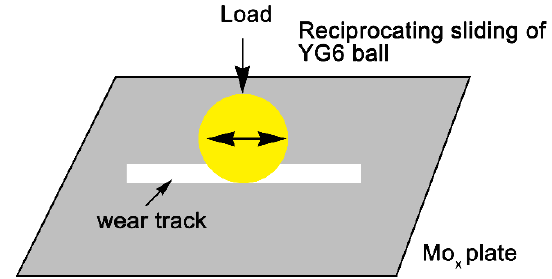
Figure 1. Schematic diagram of reciprocating